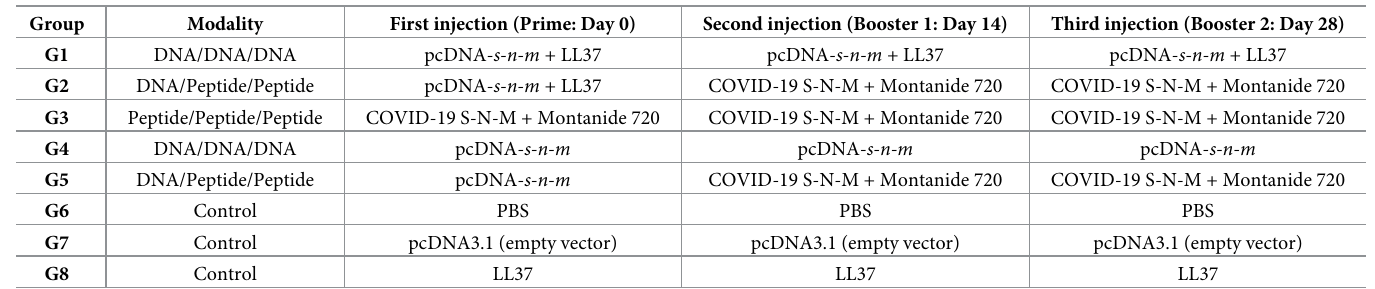
Table 1. Mice immunization